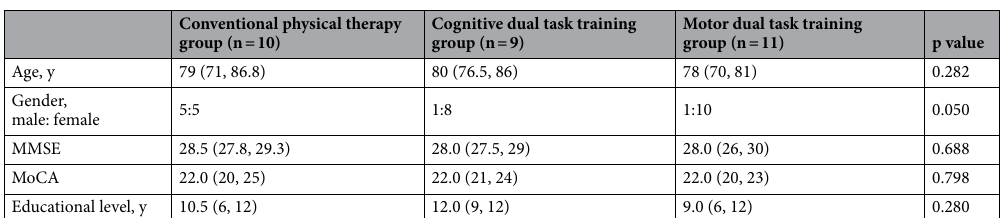
Table 1. Basic data of participants. Values are median (interquartile) or frequency. MMSE Mini Mental State Examination, MoCA Montreal Cognitive